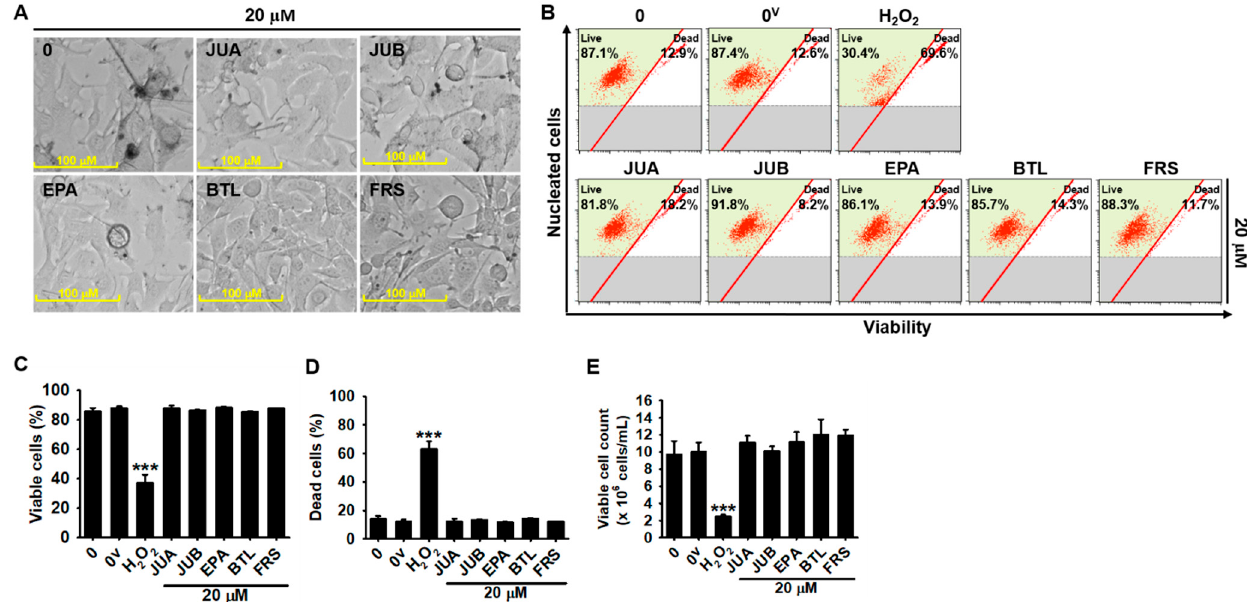
Figure 2. Flavonoid glycosides from Z. jujuba var. inermis (Bunge) Rehder seeds present no cytotoxicity in B16F10 melanoma cells. B16F10 melanoma cells (5 × 10 4 cells/mL) were treated with 20 µM of jujuboside A (JUA), jujuboside B (JUB), epiceanothic acid (EPA), betulin (BTL), and 6’’’-feruloylspinosin (FRS) for 96 h. ( A ) Images of the cells were captured using a phase contrast microscope (×20). Scale bar = 100 µm. ( B ) Cell viability was analyzed by a Muse Cell Count and Viability Assay Kit. ( C ) Viable cell (%) and ( D ) dead cell (%) population, and ( E ) viable cell count (× 10 6 cells/mL) are shown. Hydrogen peroxide (H 2 O 2 , 100 µM) was used as a cellular death-inducing positive control. All data are presented as a standard error of the median from three independent experiments (*** p < 0.001 vs. untreated cells). 0, Untreated control; 0 v , vehicle control (0.01% DMSO).